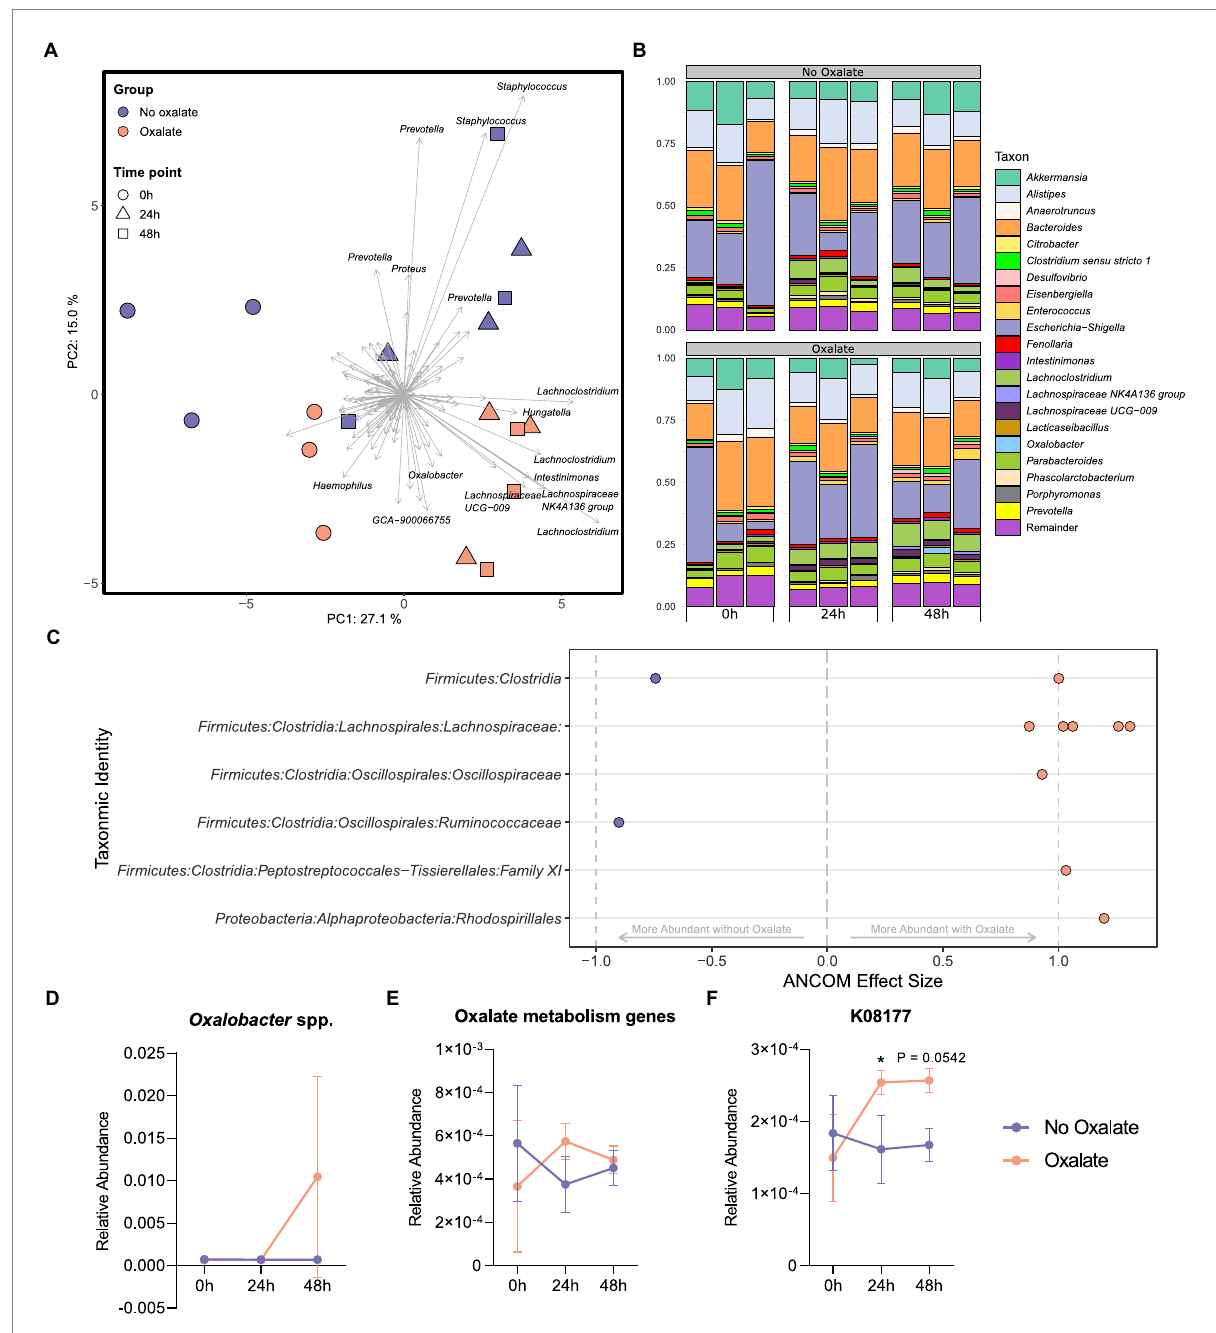
FIGURE 5 Microbiota analysis of oxalate samples inoculated with chemostat culture. (A) Principal component analysis (PCA) plot of ASVs from sample bacterial communities. Centre log ratio-transformed Aitchison distances of sequence variants were used as input values for PCA analysis. Distance between samples on the plot represents differences in microbial community composition. Approximately 42% of the total variance is explained by the first two components shown. Strength and association for sequence variants are depicted by the length and direction of arrows shown. Points are colored by oxalate exposure and shapes denote time point ( n = 3). (B) Relative abundance bar plot of longitudinal samples. Each vertical bar denotes relative sequence variant abundance (collapsed at genus-level identification). Bars are grouped by time point. (C) Analysis of differences in sequence variant abundance with oxalate supplementation controlling for the variation associated with time. Positive values indicate sequence variants that were increased with oxalate supplementation and negative values indicate sequence variants that were decreased. Taxa are defined by the most accurate level of classification. Effect size was computed with ANCOM ( W ≥ 0.7) and supported with MaAsLin2 (Benjamini–Hochberg adjusted p < 0.05). (D) Longitudinal relative abundance of Oxalobacter spp. Data displayed as mean ± SD. Statistical comparisons using two-way ANOVA with Šídák’s multiple comparisons test ( n = 3). (E, F) Relative abundance of predicted oxalate degrading KEGG Orthology numbers over time. Data represents mean ± SD. (E) Sum of all predicted oxalate degrading KEGG Orthology numbers (K08177, K01596 [EC:4.1.1.2], K01577